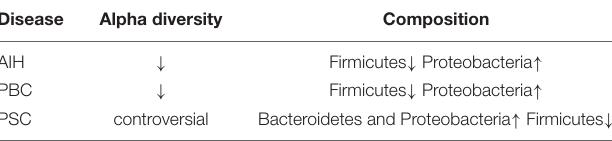
TABLE 1 | Changes of gut microbiome in autoimmune liver diseases (AILDs).